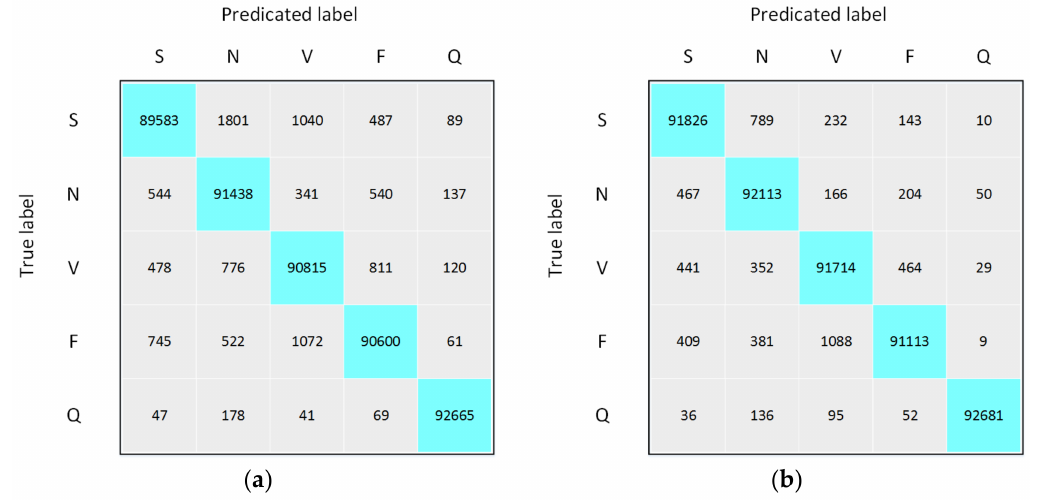
Figure 10. Confusion matrixs for LiteNet on set A ( a ) and set B ( b